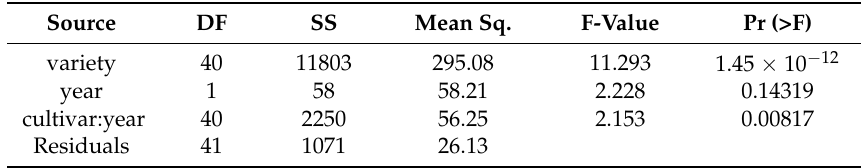
Table 1. Results of an analysis of variance (ANOVA) showing an interaction output for total content of stilbenoids by year from different muscadine grapes (2013–2015). Source DF SS Mean Sq. F-Value Pr (>F) variety 40 11803 295.08